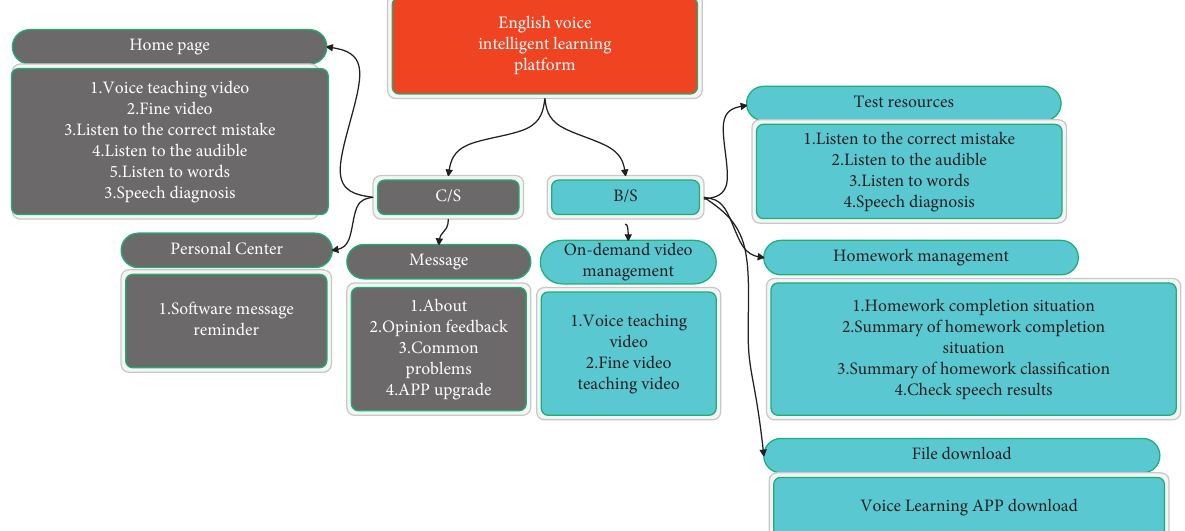
Figure 7: Core framework of AI virtual English reading